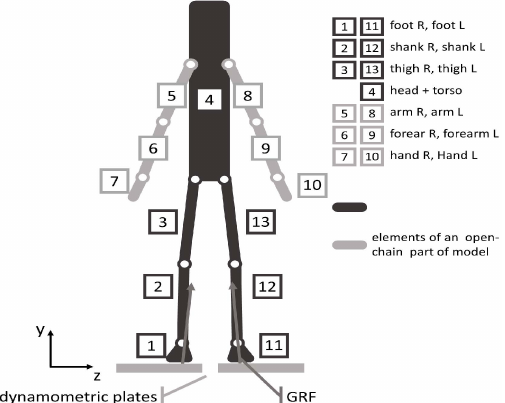
Figure 3. Front view (in the plane XY) on the biomechanical model.